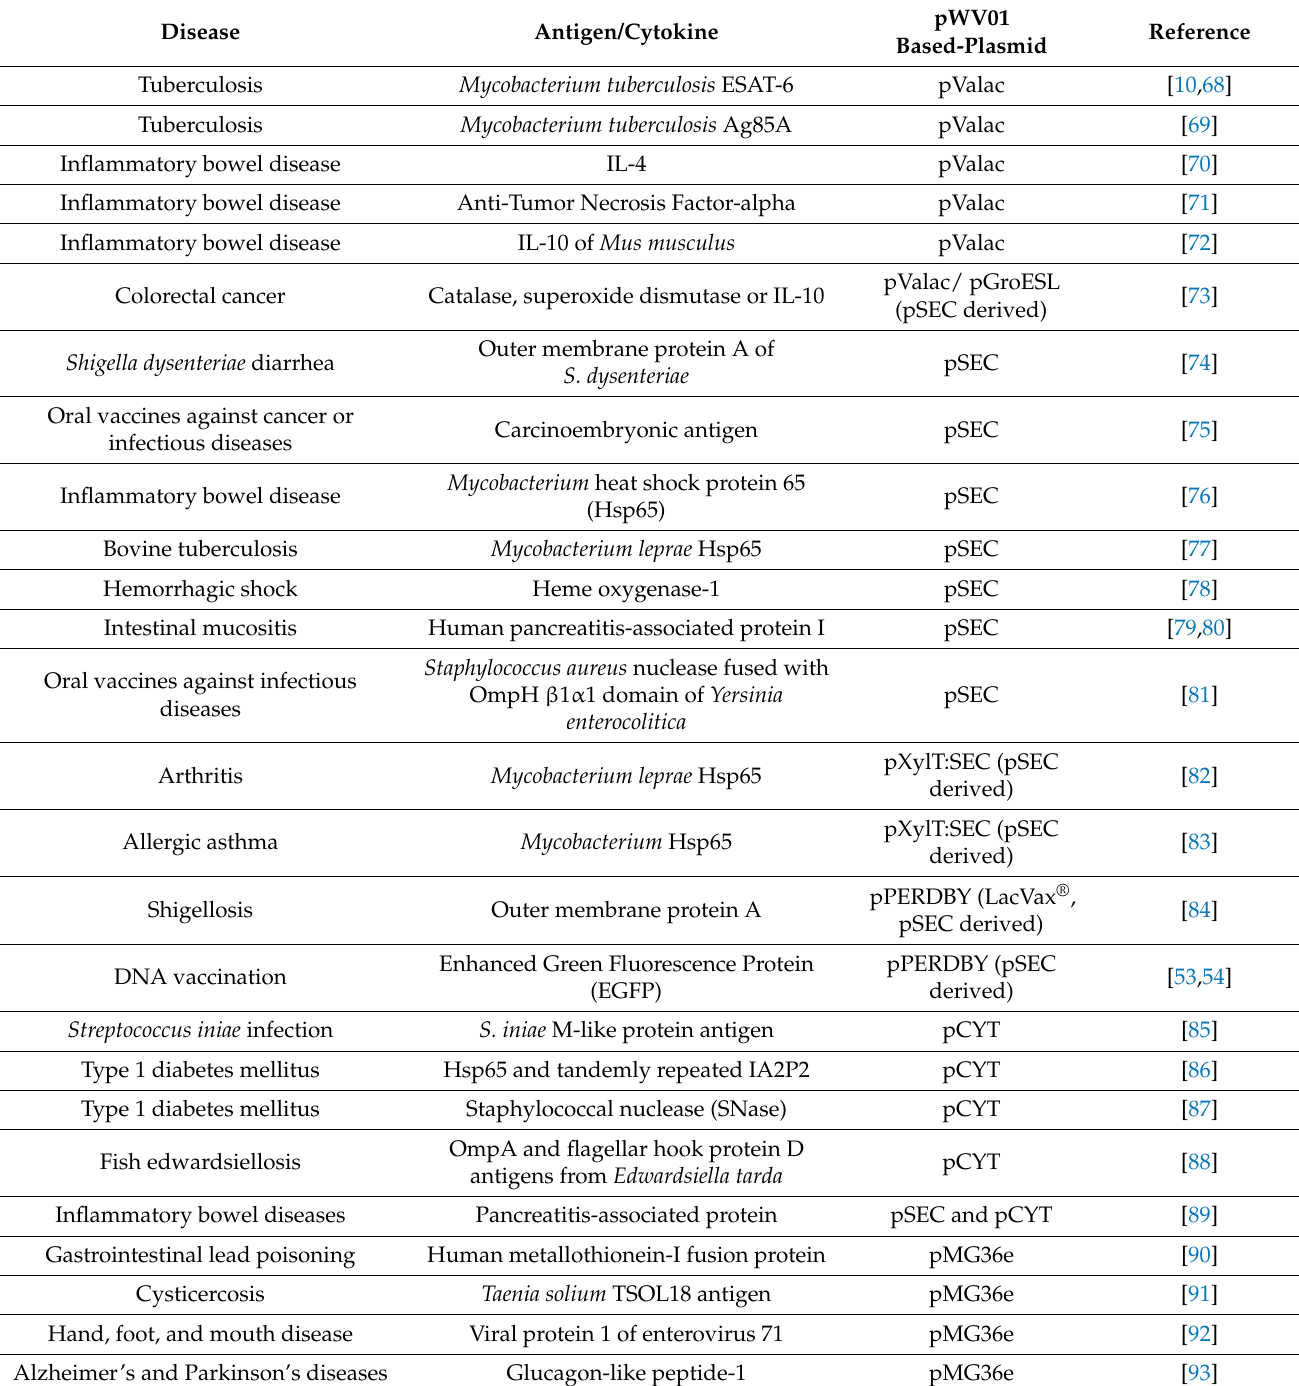
Table 2. Plasmids with a pWV01 origin of replication used as antigen-expressing vectors in L. lactis host, for mucosal vaccination purposes against several